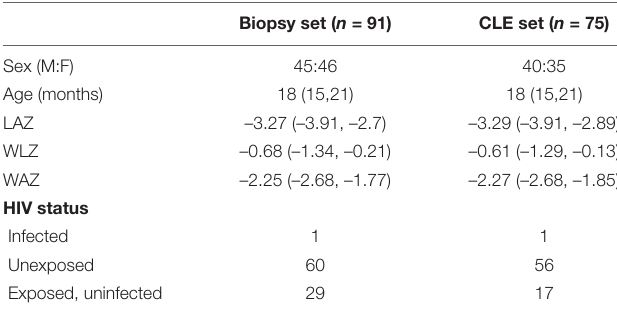
TABLE 1 | Clinical and demographic characteristics of children who had biopsies and the subset who had confocal laser endomicroscopy. Biopsy set ( n =